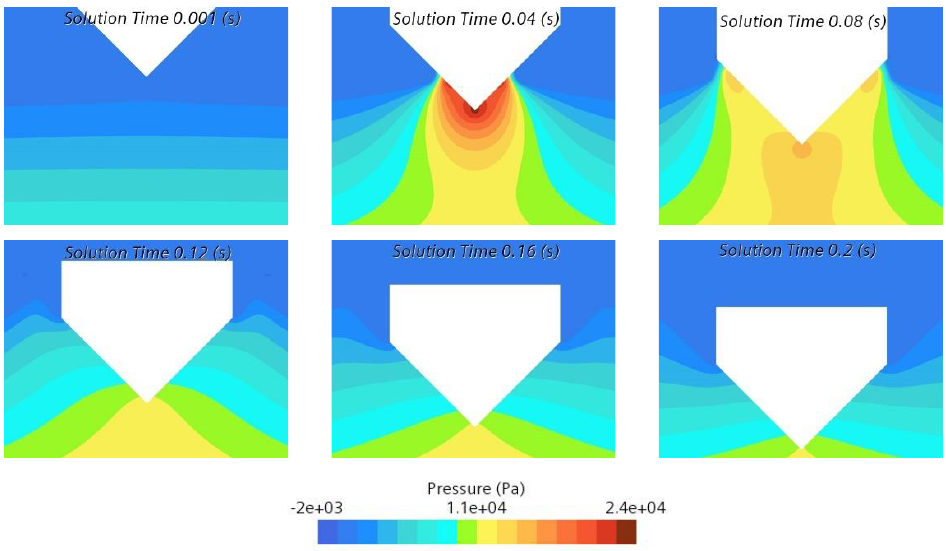
Figure 20. Pressure distribution of fluid domain at different time (Case 4).